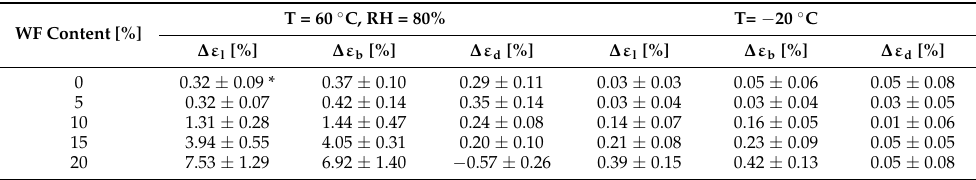
Table 2. Dimensional stability of PUR foam with different amounts of wood filler acclimated under different